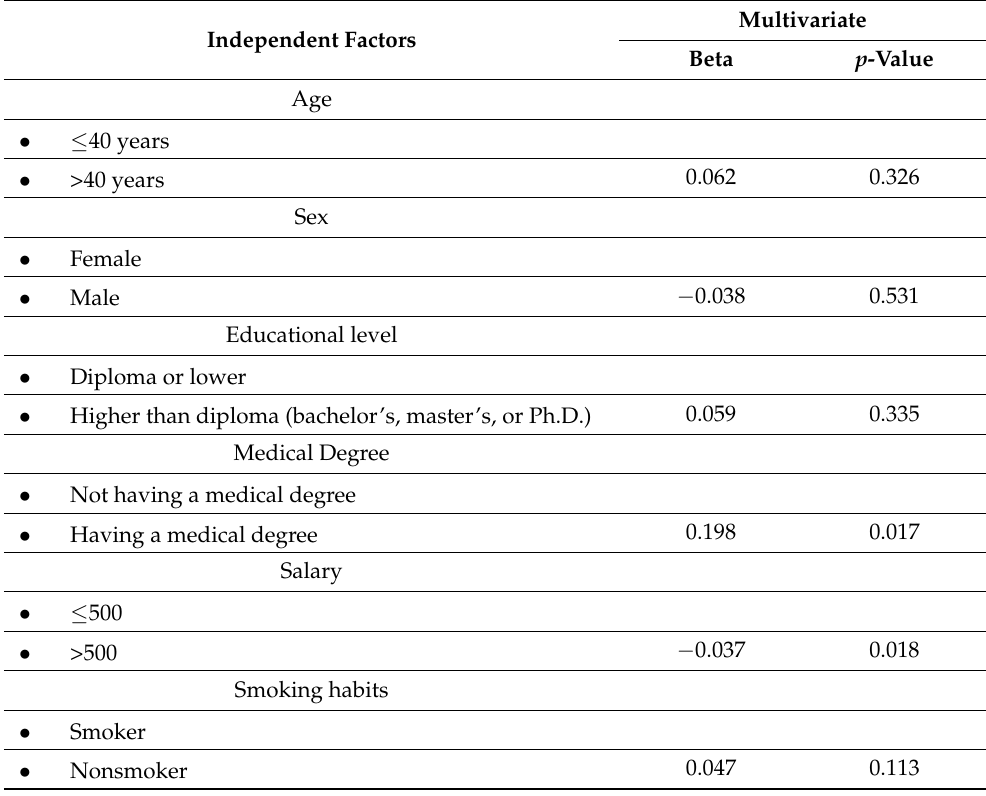
Table 2. Overall logistic regression analysis (multivariate) to evaluate predictors related to partici- pants’